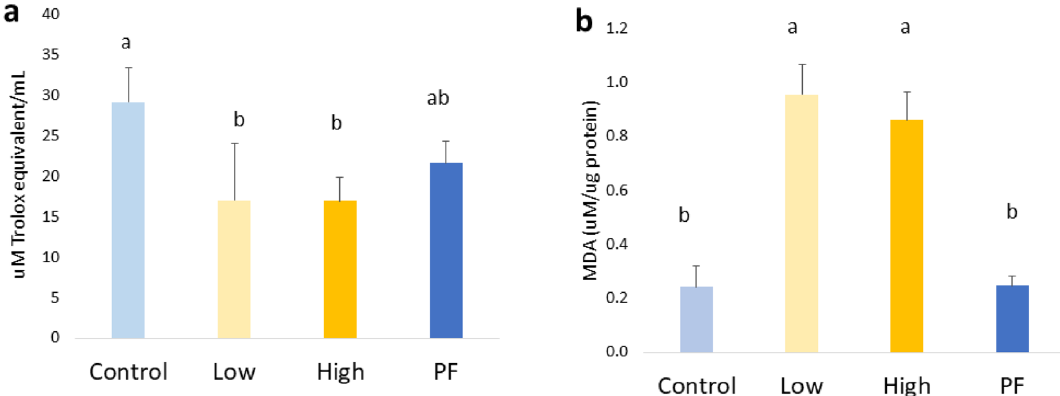
Figure 6. Oxidative status at 6 dpi. ( a ): serum total antioxidant capacity was measured by antioxidant assay kit, that coccidial infection significantly decreased the antioxidant capacity ( P = 0.001). ( b ): liver lipid peroxidation was measured by TBAR assay kit, that coccidial infection significantly elevated lipid peroxidation in liver ( P < 0.001). Control, non-challenge control group; Low, the low challenge dose of Eimeria; High, the high challenge dosage of Eimeria; PF, pair-feeding group that paired with High group. a,ab,b Treatments with different letters means a significantly difference between treatments by using Tukey’s HSD test, P < 0.05, N =